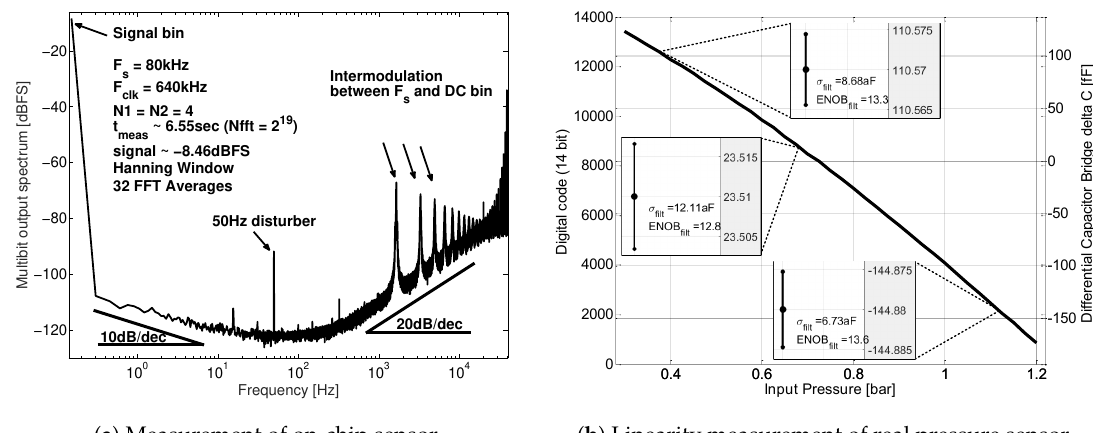
( b ) Linearity measurement of real pressure sensor Figure 13. Long-term spectral approximation of on-chip dummy bridge measurement to reveal circuit characteristics such as noise-shaping, flicker-noise, tonal behavior and potential measurement disturbers ( a ); CDC system linearity plot (CDC + real pressure sensor): input pressure vs. digital reading and equivalent bridge capacitor difference, respectively. The pressure step size is 25 mbar and σ filt is after 1024 consecutive measurements ( b